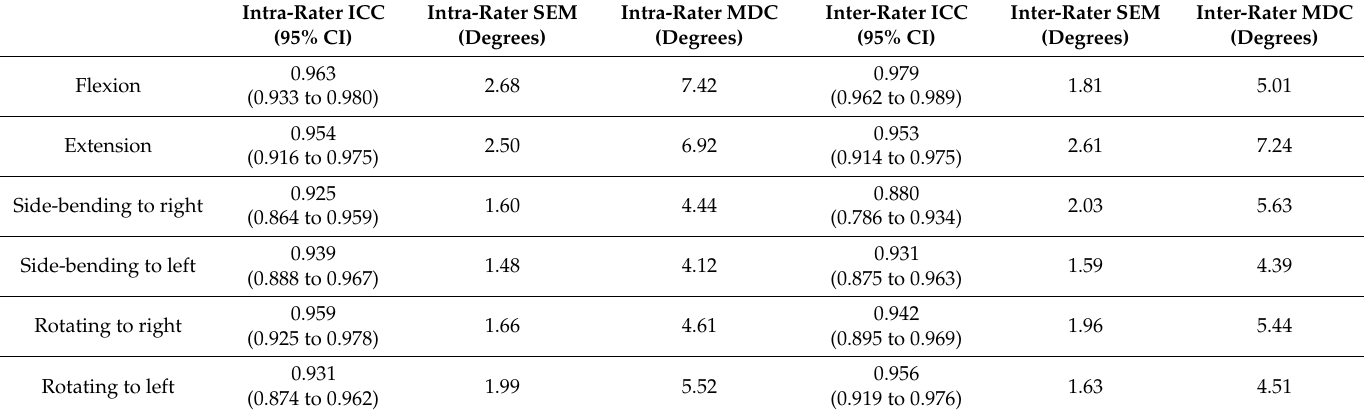
Table 2. Intra-rater and inter-rater reliability of craniocervical ranges measured by the hybrid